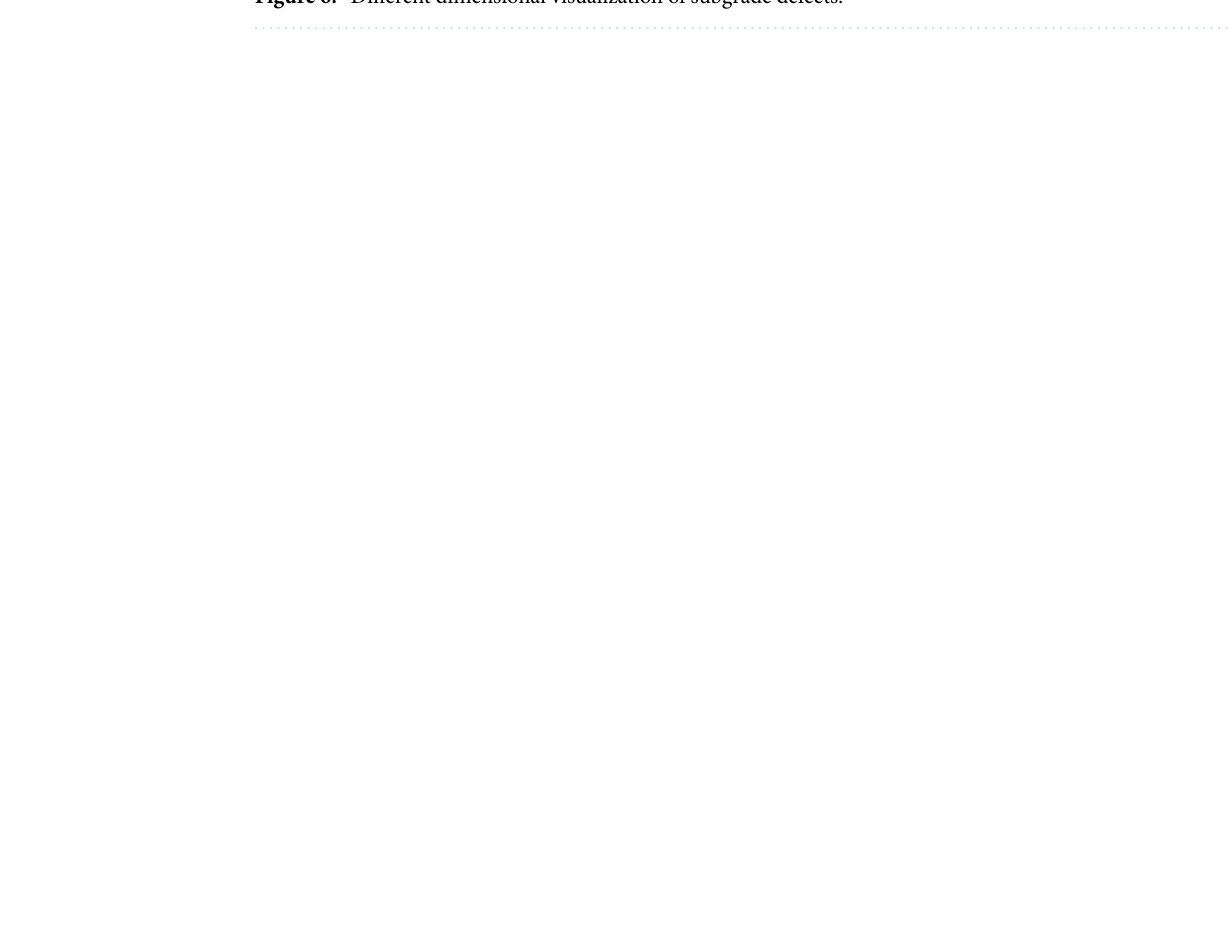
Figure 6. Different dimensional visualization of subgrade